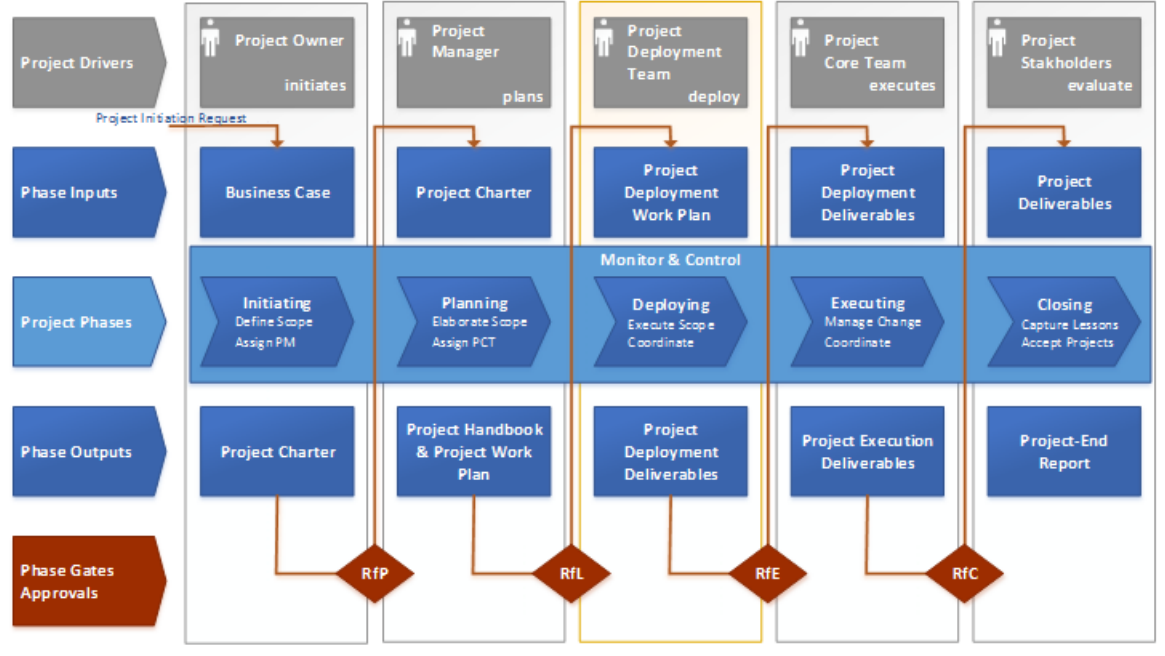
Figure 4. Swimline diagram for sports events